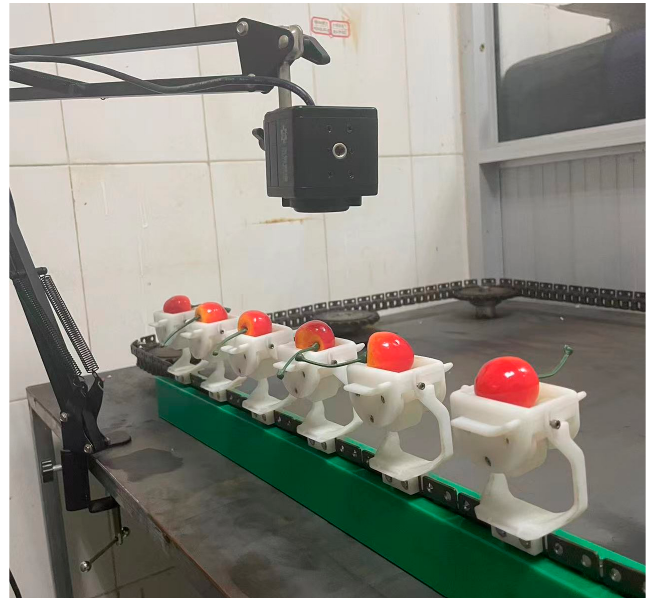
Table 5. Comparison of optimization results with actual values.